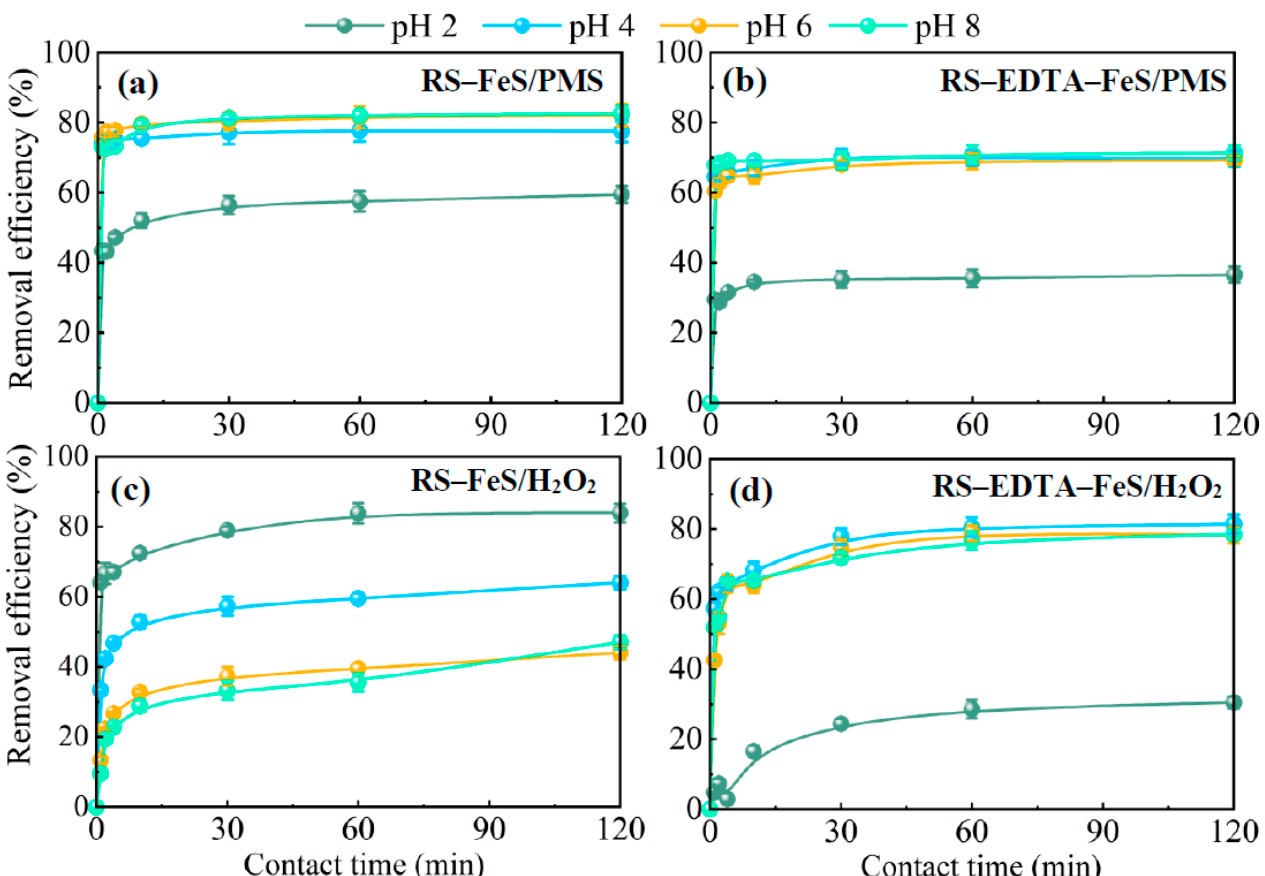
Figure 4. The effect of different initial pH on OTC removal efficiencies from the RS–FeS/PMS ( a ), RS–EDTA–FeS/PMS ( b ), RS–FeS/H 2 O 2 ( c ), and RS–EDTA–FeS/H 2 O 2 ( d ) system (C 0 = 20.00 mg L − 1 , [PMS] = 0.20 g L − 1 , [H 2 O 2 ] = 6.60 mM).